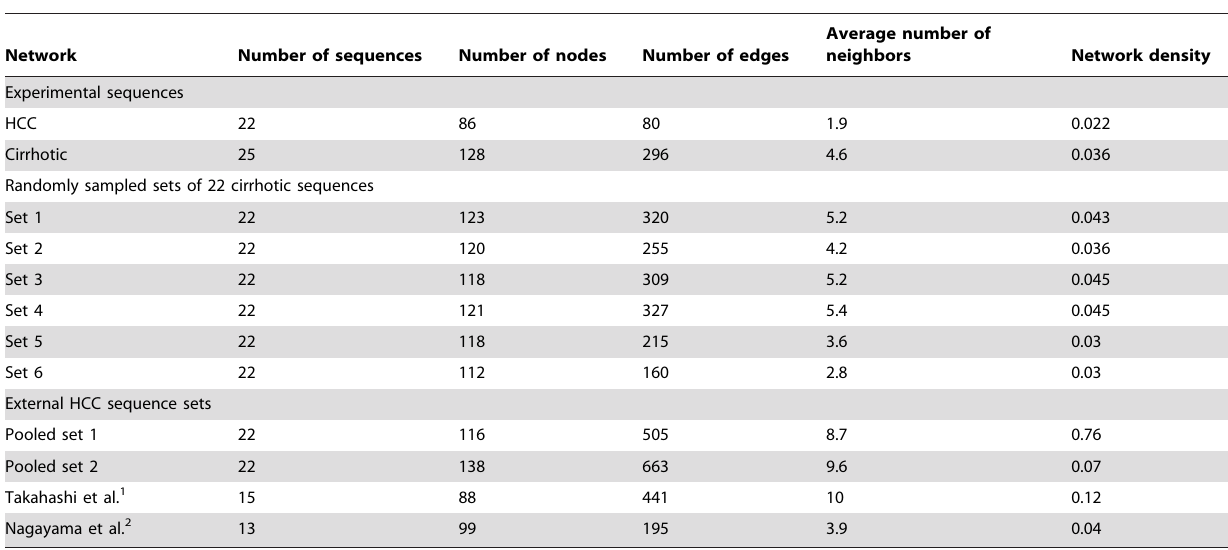
Table 4. Basic amino acid covariance network parameters for the HCC and cirrhotic sequences.